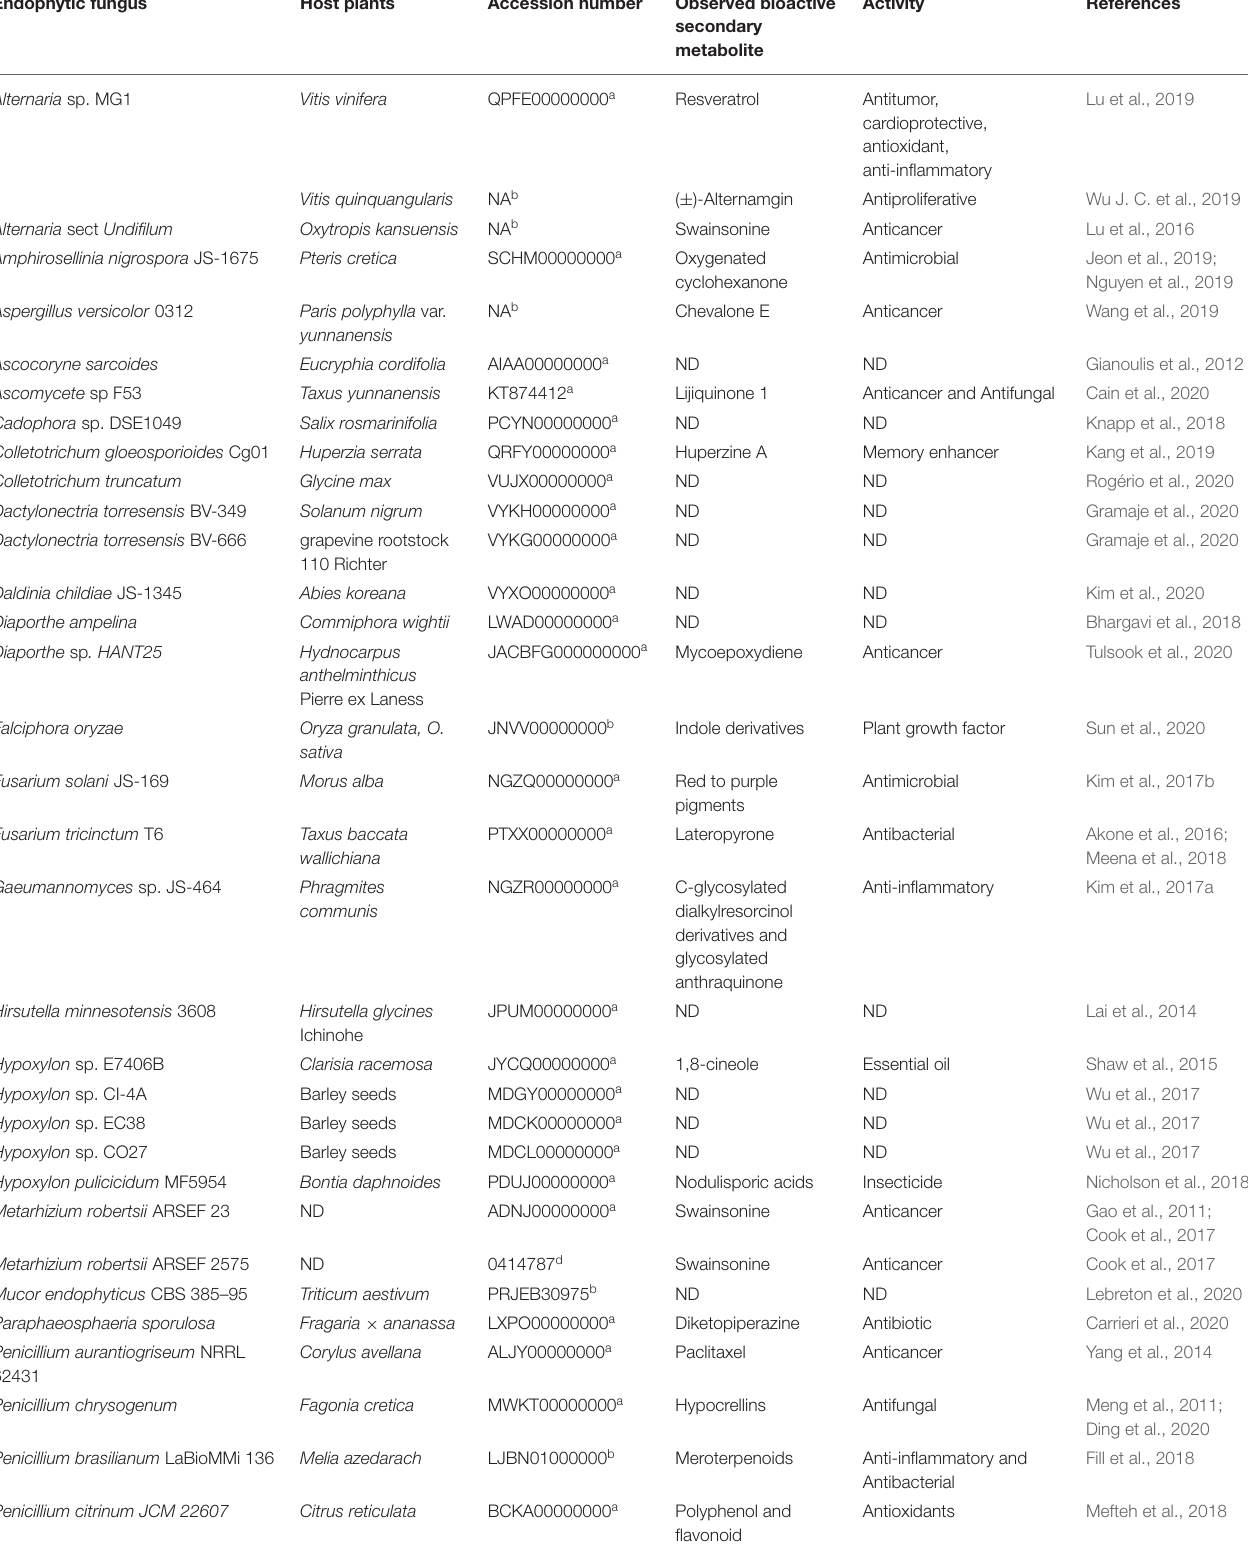
TABLE 3 | List of endophytic fungi subject to whole genome sequencing projects referenced in the